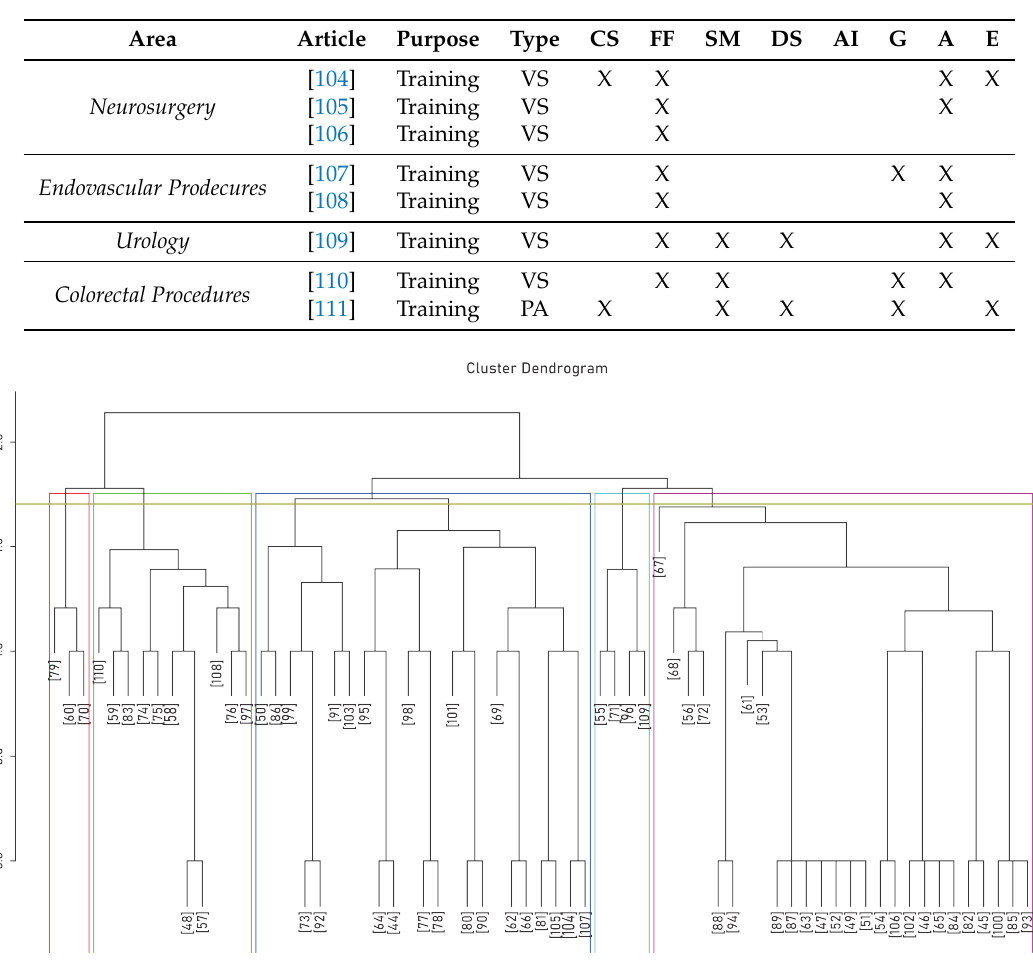
Figure 4. Cluster dendrogram. A hierarchical clustering to generate research groups was performed. Using the value of h = 1.7, each cluster was evaluated to find their principal characteristic.